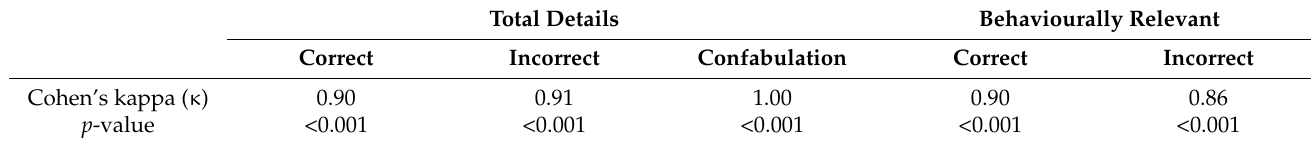
Table note: A p -value < 0.001 indicates that the level of inter-rater agreement observed is different from what would be achieved by chance alone.